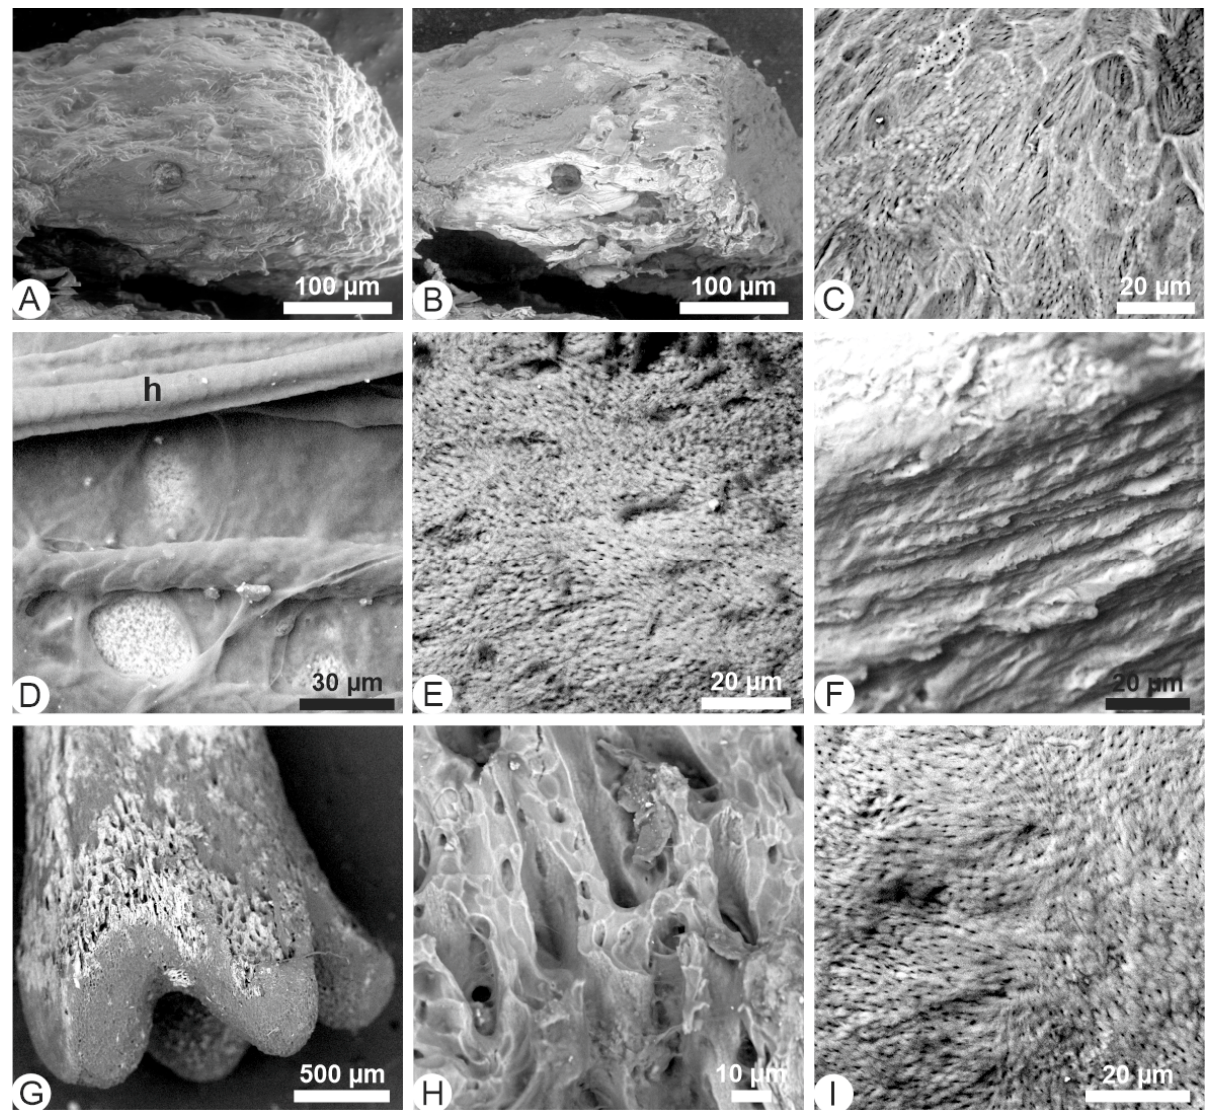
Figure 1. Fresh bone samples. A, B. Mus musculus: secondary electron (SE) SEM image ( A ) and back-scattered electron image (BSE) of the same zone ( B ); BSE image reveals the presence of organic tissues on the surface (in dark). ( C ). Resorbing surface and the haversian system femur. ( D ). Hairs on the same bone. ( E ). Inner structure of the bone. ( F ). Lamellar bone visible in some fractures; same bone. ( G ). Humeral epiphysis of Apodemus ; BSE image shows the light region (mineral) and the dark zones (organics). ( H ). Porosity and resorption patterns. ( I ). Haversian system in a bone of Apodemus .